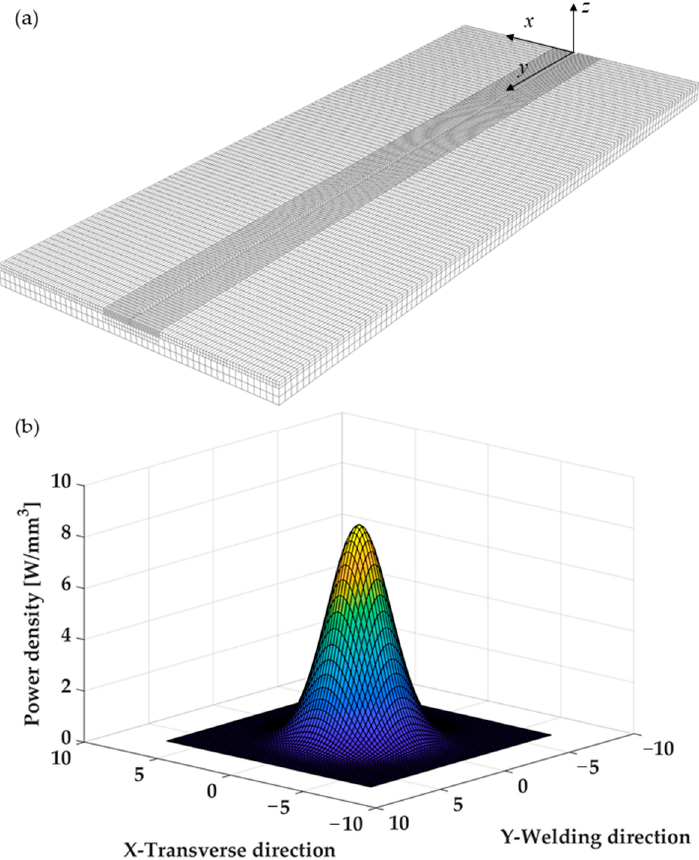
Figure 6. ( a ) Mesh used for the FE simulations. ( b ) Heat flux at top layer (z = 0) and in the local reference system using the double ellipsoid power density distribution function, as proposed by Goldak and using the following parameters: p 0 = 1000 W, k 1 = 4 mm, k 2 = 4 mm, k 3, f = k 3, r = 5 mm.